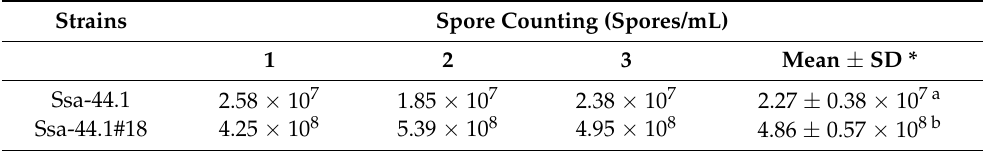
Table 1. Effect of CgRV2 on sporulation level of C. gloeosporioides . Strains